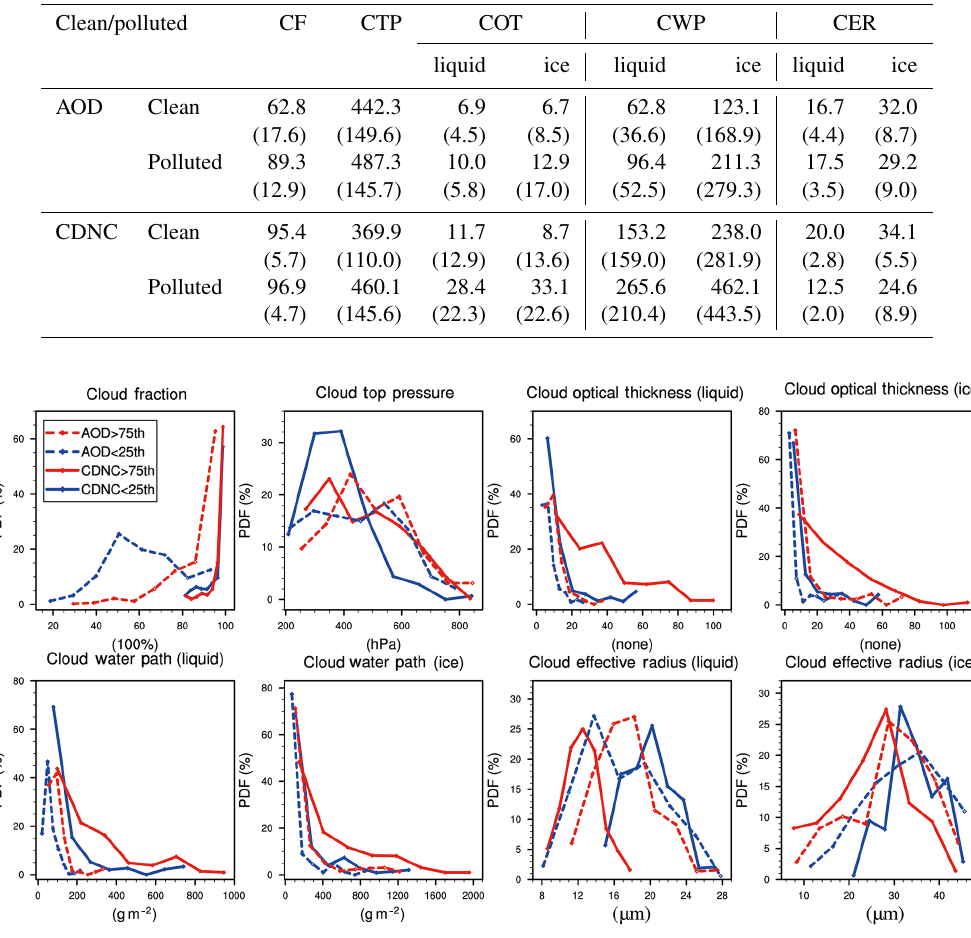
Figure 9. PDFs of CF (units: %), CTP (units: hPa), COT (liquid and ice, units: none), CWP (liquid and ice, units: gm − 2 ) and CER (liquid and ice, units: µm) on selected clean (blue dash lines: AOD < 25th percentile; blue solid lines: CDNC < 25th percentile) and polluted (red dash lines: AOD > 75th percentile; red solid lines: CDNC > 75th percentile) heavy rainfall days. All cloud variables are obtained from the MODIS C6 cloud